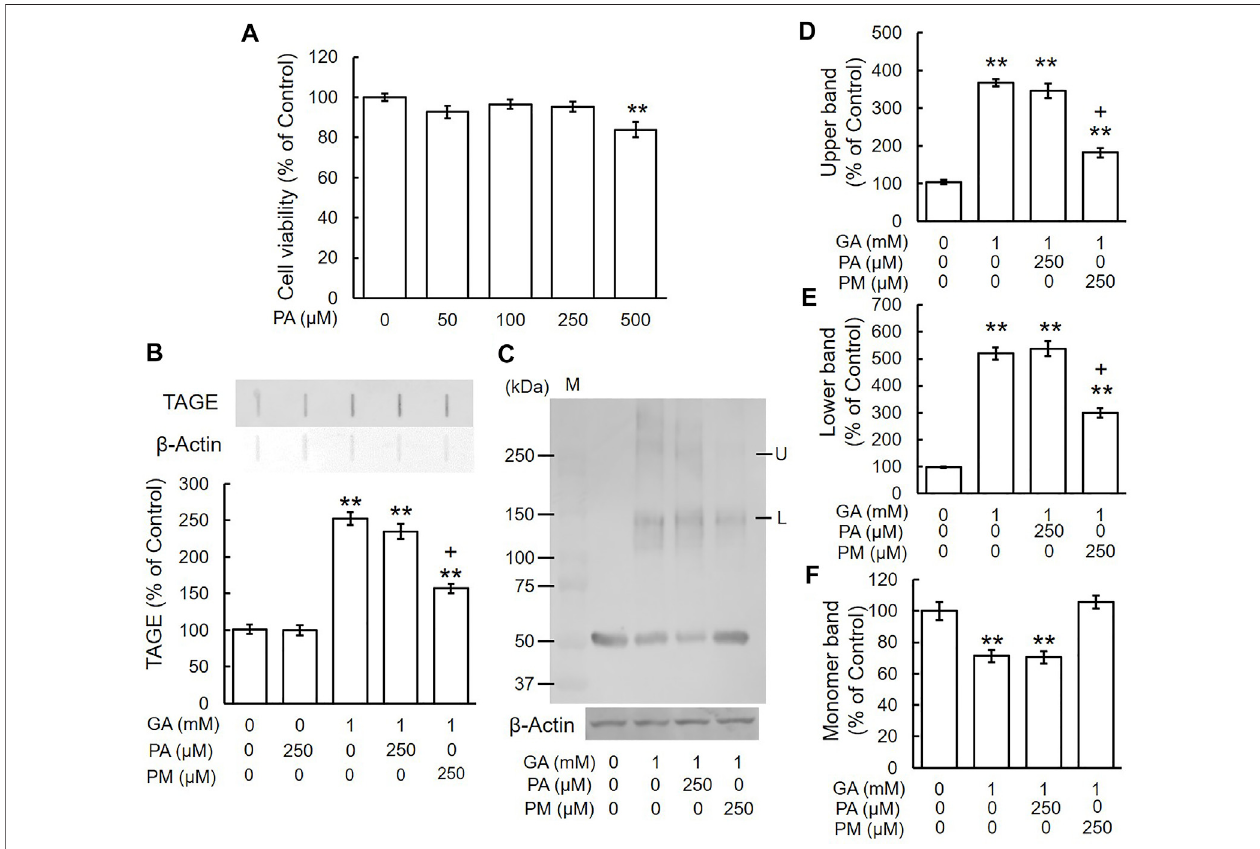
FIGURE 5 | PA did not inhibit TAGE formation and β -tubulin aggregation by GA. (A) Cell viability following PA treatment. ** p < 0.01 vs. 0 μ M ( n = 6). (B) The levels of TAGEformation determinedbyslotblotanalyses. ** p < 0.01vs. vehiclecontrol, + p < 0.01vs. GAalone ( n = 3). (C) Thelevels of β -tubulin were detectedusing anti- β -tubulin antibody.M:Marker,L:lowerband,U:upperband. (D – F) Thelevelsofupper (D) ,lower (E) andmonomer (F) bandsoftheGA-treated β -tubulin.** p < 0.01vs.vehiclecontrol, + p < 0.01 vs. GA alone ( n =